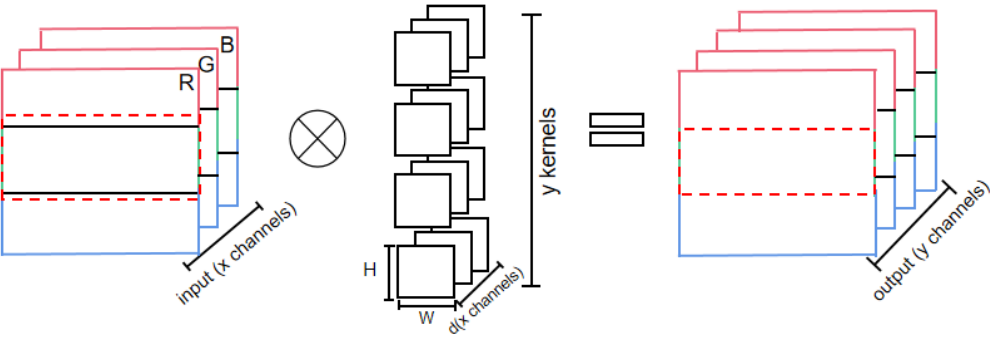
Figure 2. Partitioning method for convolutional layer (number of devices = 3).